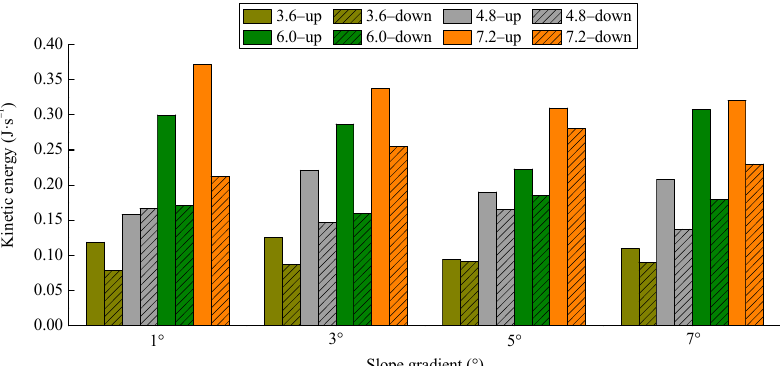
Figure 4. Kinetic energy values in the upstream catchment area and downstream gully bed under different slope gradients and flow discharges.